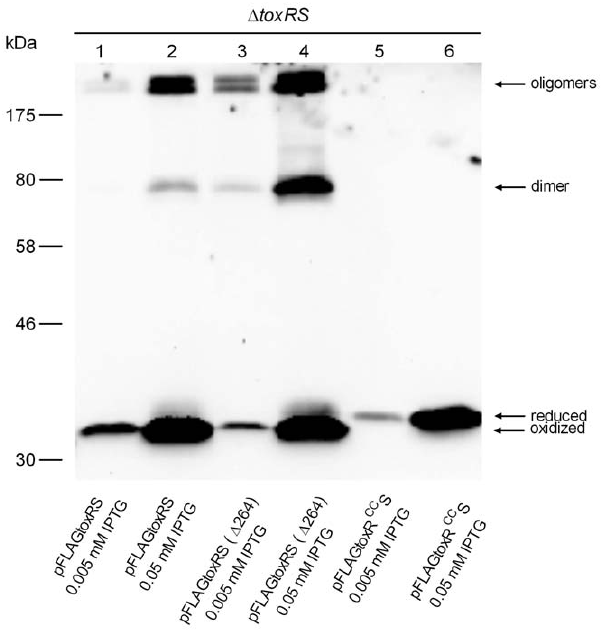
Figure 2. toxRS coexpression in V. cholerae P27459-S D toxRS mutant strain acts negatively on ToxR disulfide bond homo- dimer and oligomers. Shown is an immunoblot analysis derived from SDS-PAGE analysis performed under non-reducing conditions, utilizing anti-FLAG antibodies and V. cholerae cells harboring various pFLAG- toxRS expressing plasmids, grown in LB medium to mid-log phase and induced with IPTG. Molecular markers are indicated on the left side. Two different IPTG concentrations are indicated, showing different ToxR levels. Immunoblot analysis was performed at least three times, and results were